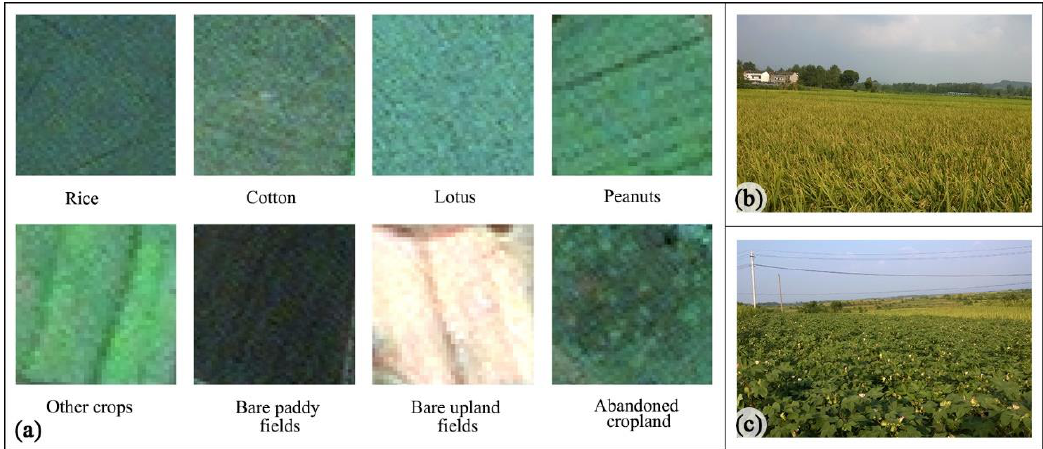
Figure 2. Image examples of eight land use categories from the WV2 image ( a ). Field photos of rice ( b ) and cotton ( c ).